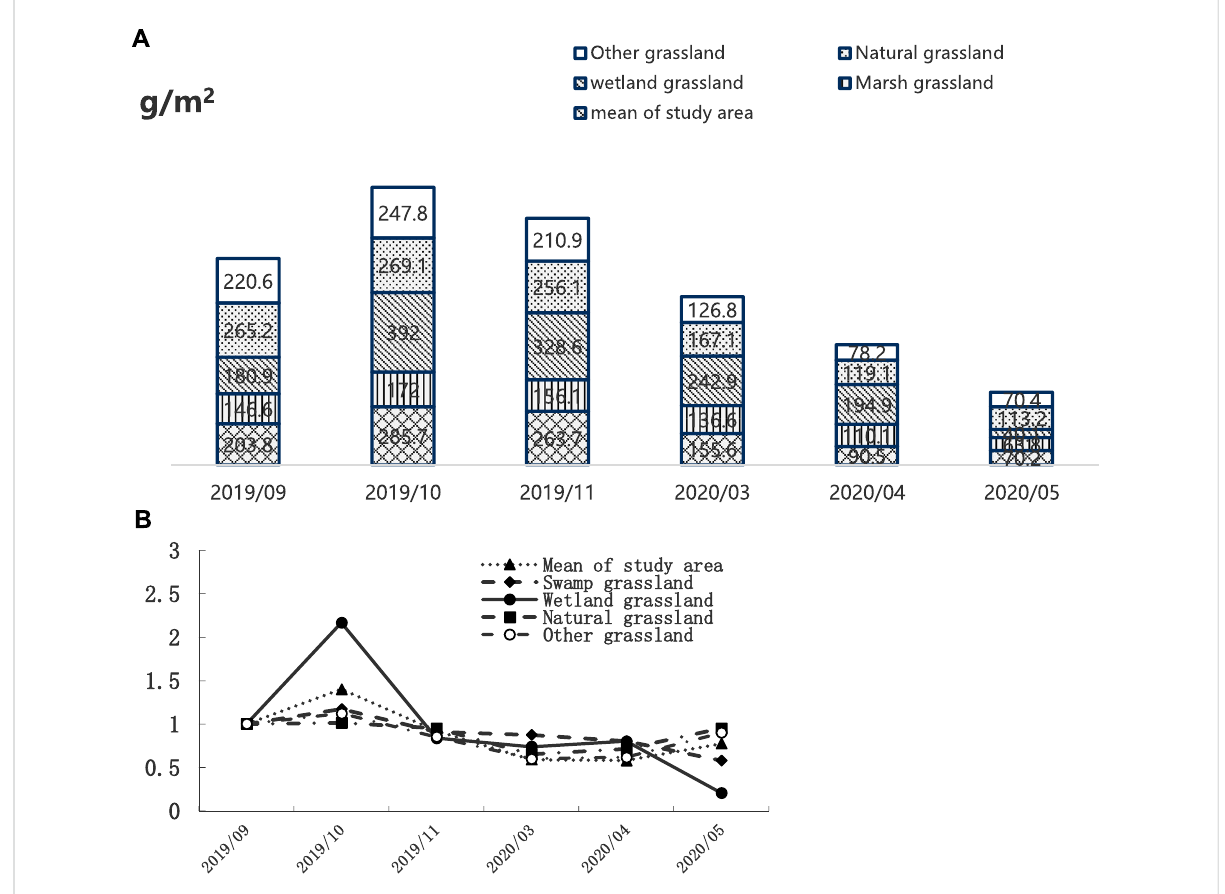
FIGURE 7 Monthly dynamic distribution chart (A) and variation curves (B) showing the amount of combustible matter in the dry